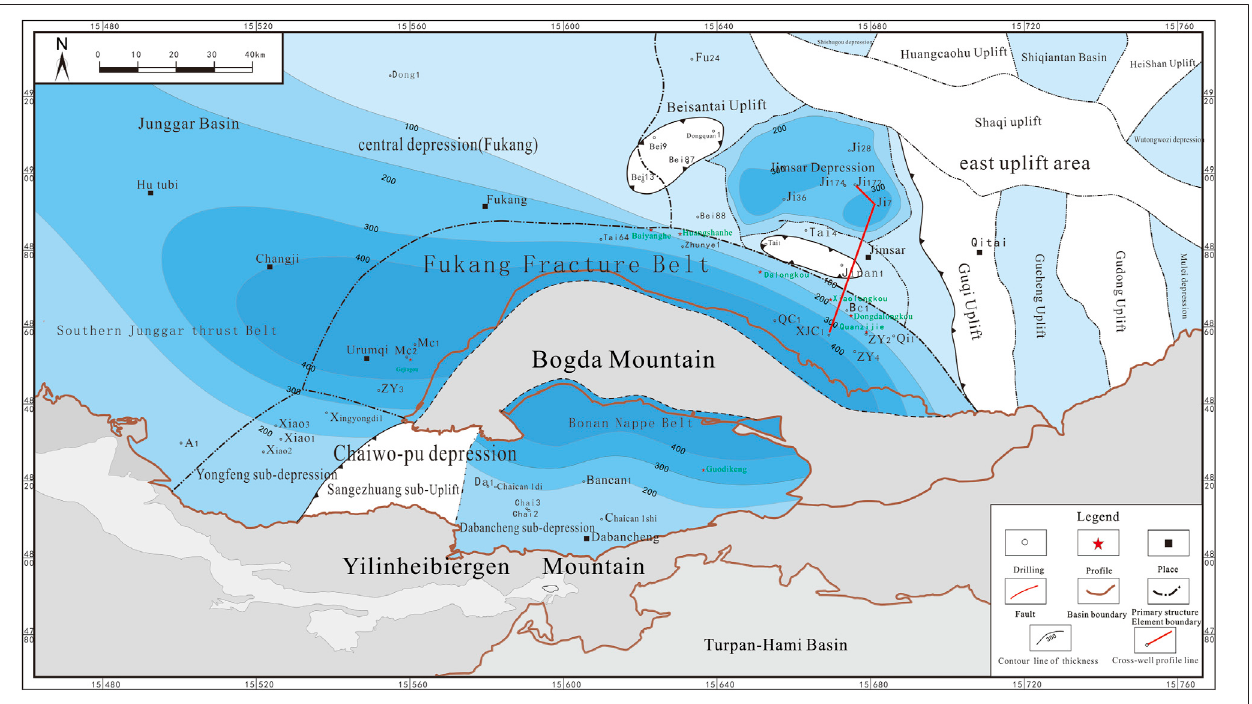
FIGURE 1 | Distribution of source rocks of Lucaogou Formation in the periphery of Bogda